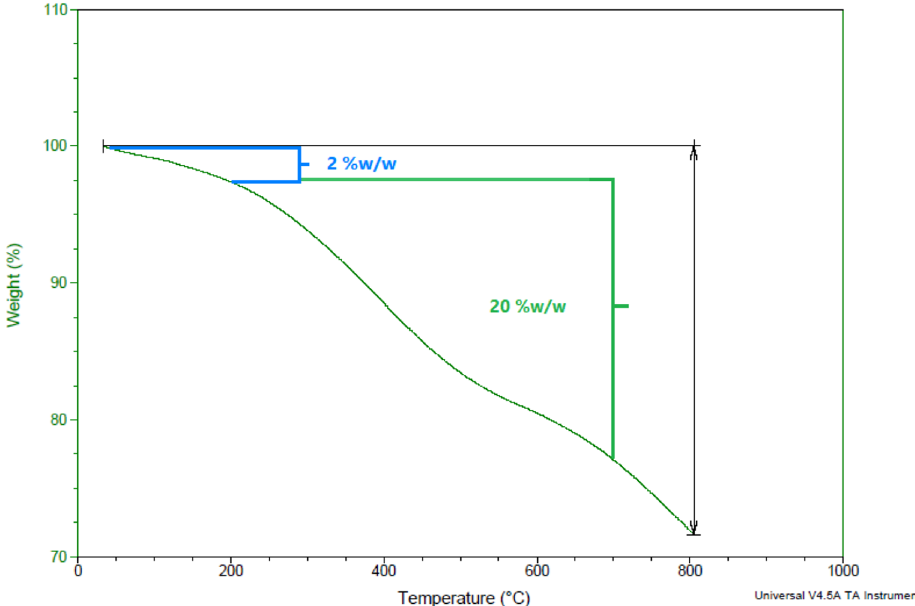
Figure 6. TGA spectrum of Cu@MCM-41-HPr-Met catalyst.